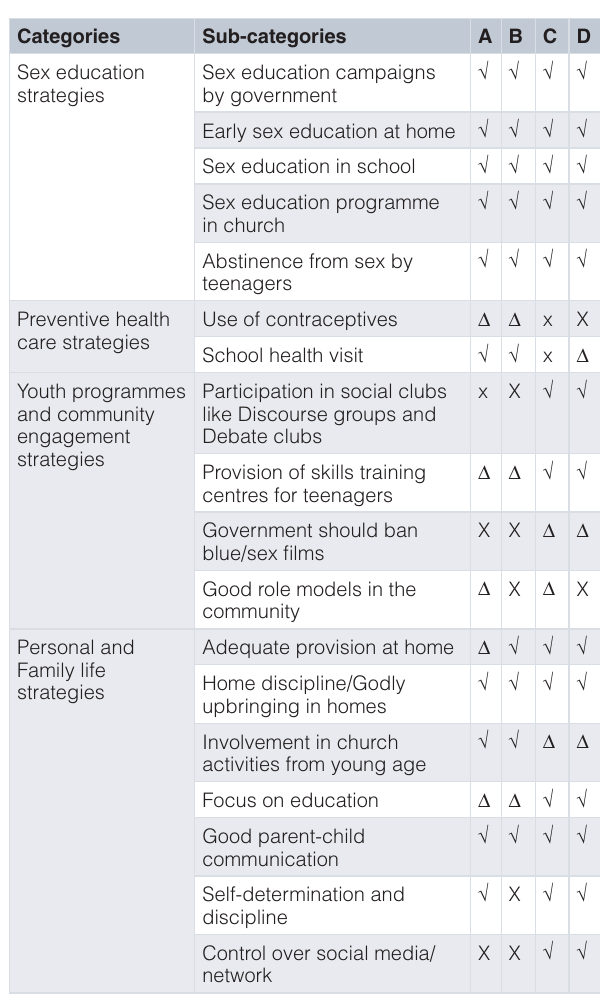
Table 5. Teenage pregnancy prevention strategies as opined by the participants. To compare the responses of the samples, the following grading scale was used: a total number of 10 responses and above (n = 20) are indicated a yes √ , indicating that the majority of the sample had the same perception; 9-5 responses are indicated with, Δ indicating that there was not a consensus perception in the sample; and 0-4 responses from the sample were indicated with an